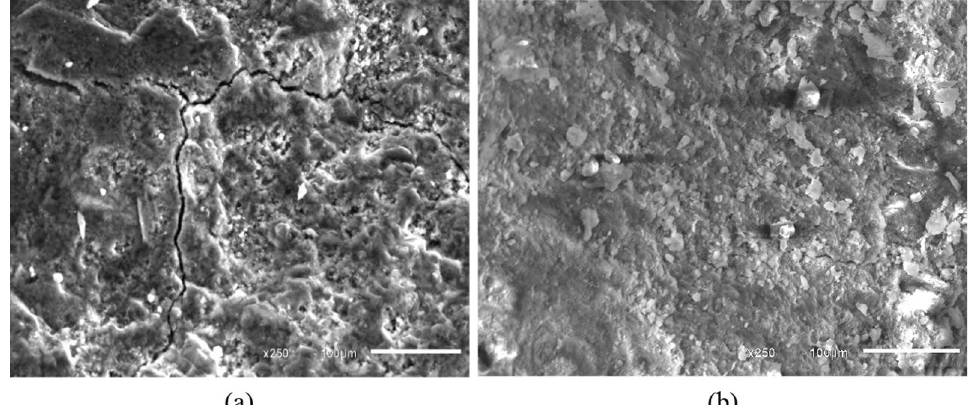
Fig. 19 SEM images for a a control sample and b a sample containing